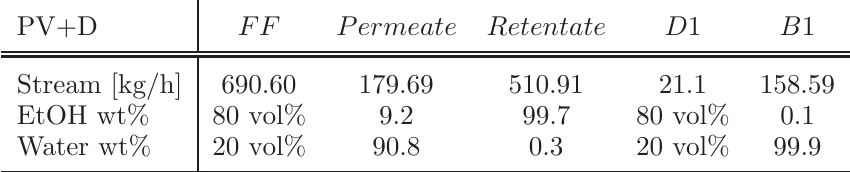
Table 2 Technological streams of isothermal pervaporation, PV+D.